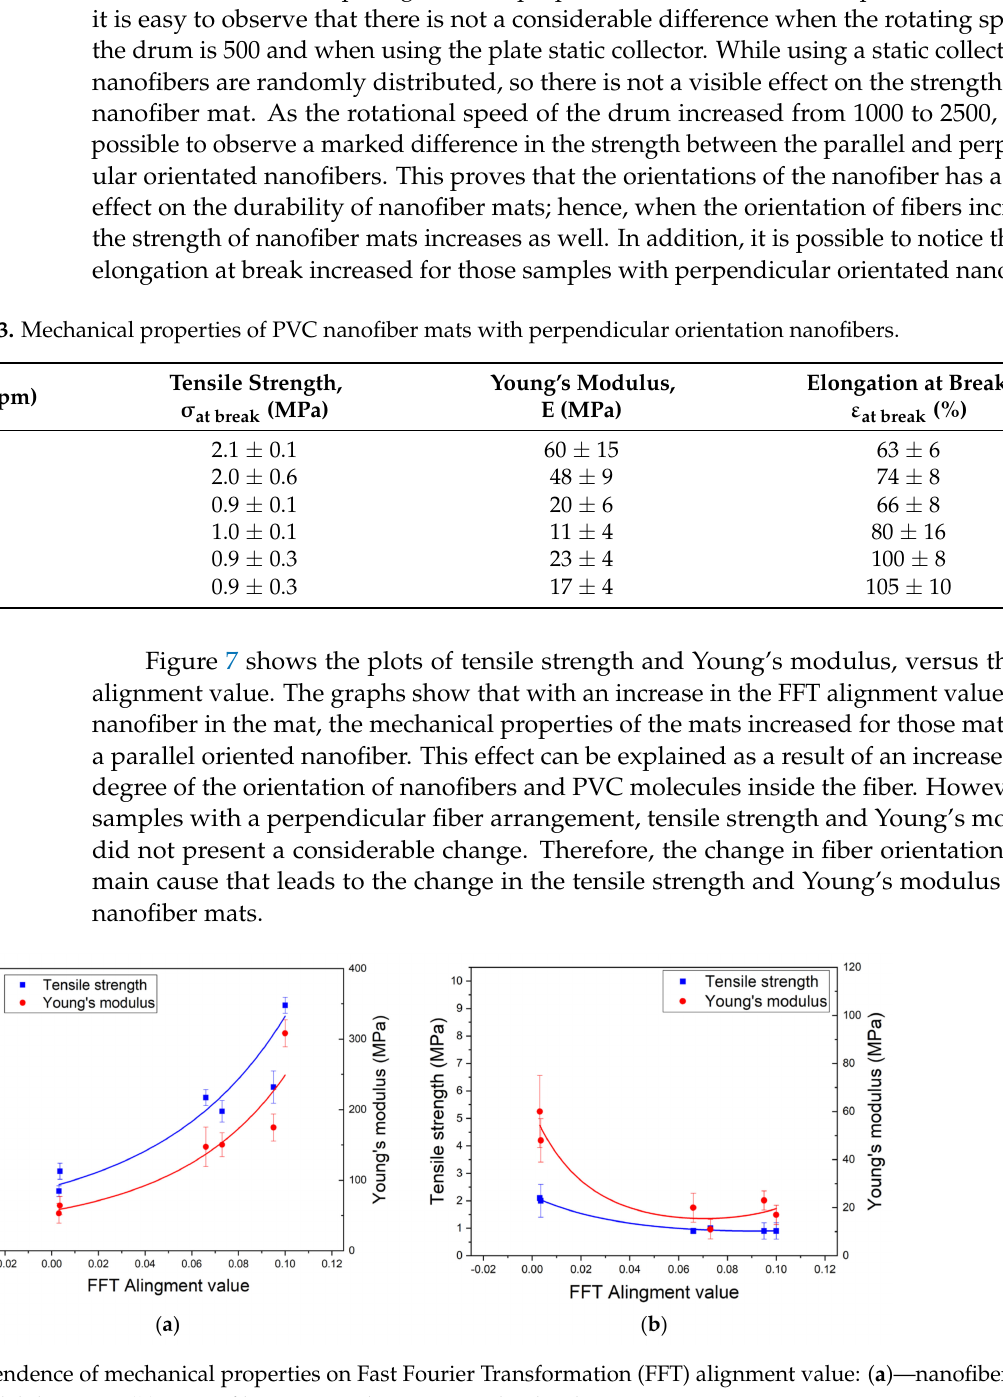
Young’s Modulus, E (MPa)